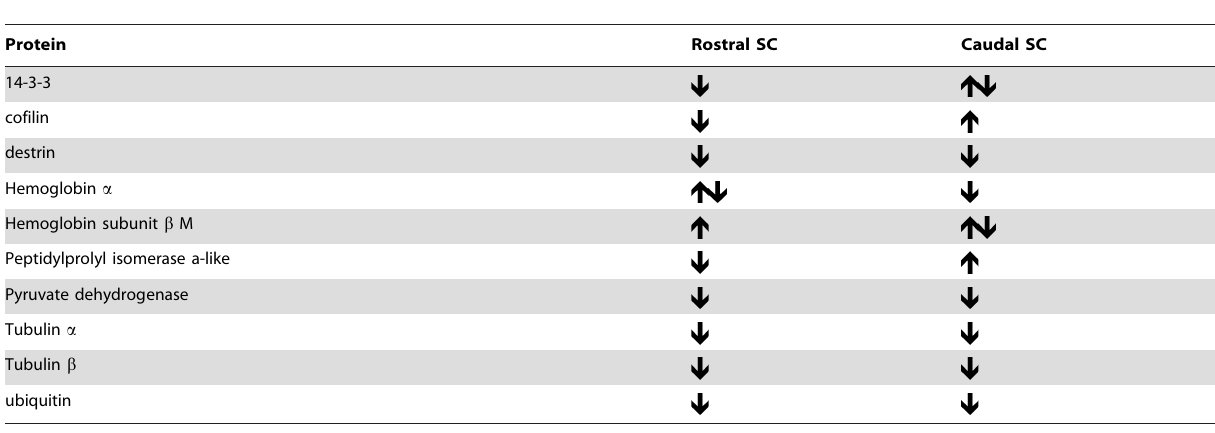
Table 6. Proteins that changed level 24 h following spinal cord injury at P7 in Monodelphis in segments rostral and caudal to site of